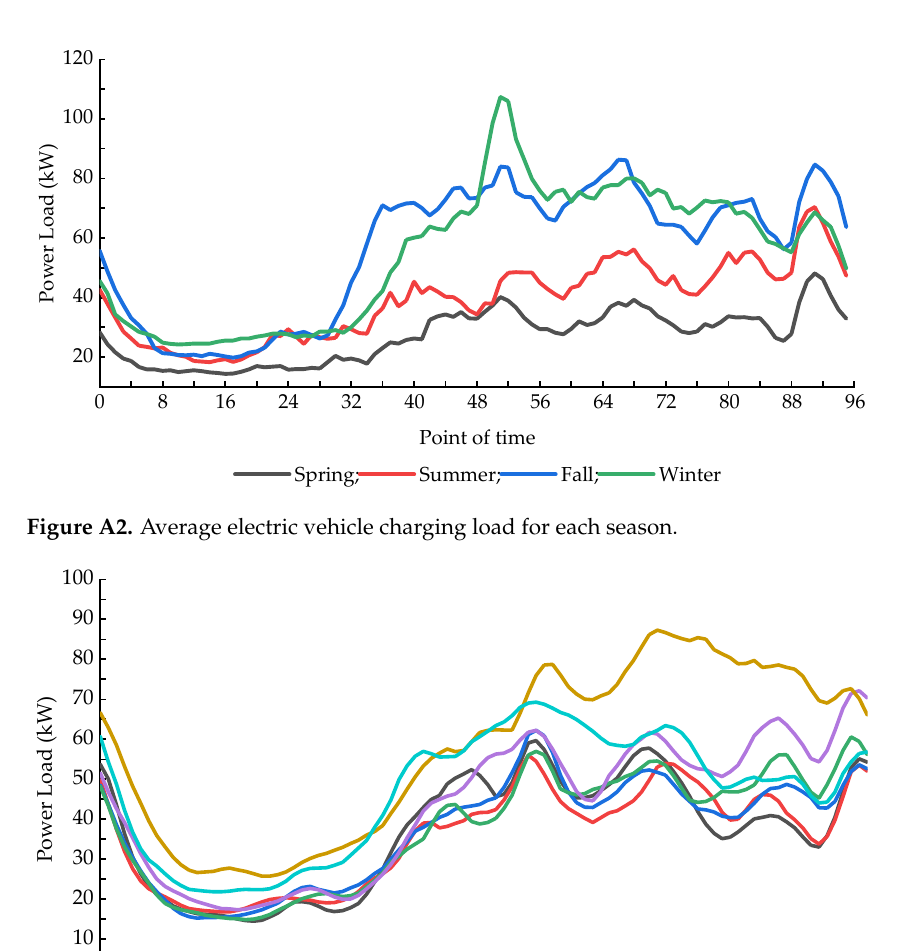
Figure A1. Average electric vehicle charging load per month.